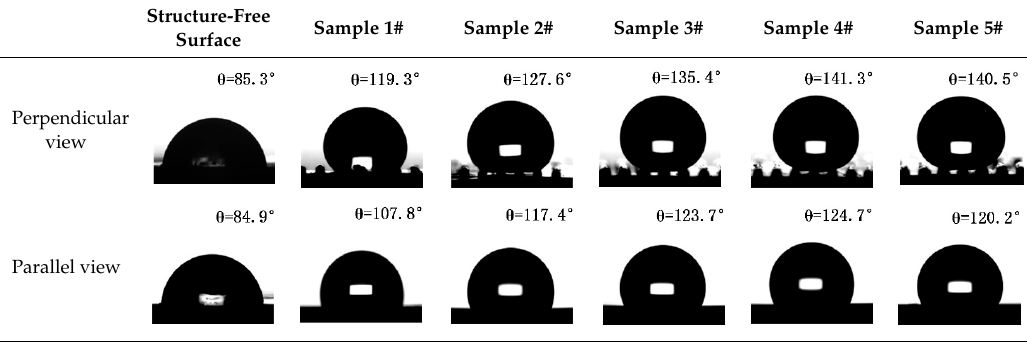
Figure 12. The evolutions of WCAs versus deposition time for PP micro-structured part surfaces. 4. Conclusion The micro-structured core insert with regular micro-groove array structure processed by WEDM-LS was applied to micro-UPM, and the micro-structure was replicated using polypropylene. This work studies the effect of micro-UPM on the processability of polypropylene under different process parameters. The primary findings are presented as follows: (1) A combined mold was assembled with an upper plate, a lower plate, a material chamber, a channel insert and a micro-structured core insert. Applying the combined mold in micro-UPM, the micro-structured parts with different shapes and sizes can be prepared, which has a simple process, low production cost and good flexibility. (2) The effect of ultrasonic energy, welding pressure and holding time was investigated for the fabricating of micro-structured PP parts during micro-UPM. The viscosity on the PP polymer was lower when ultrasonic energy is strengthened, leading to it filling in the micro-groove arrays more. Higher welding pressure allows PP melt to fill at a faster rate, reducing heat loss during the filling process. Besides, holding time is one of the critical parameters to prevent melting reflux and reduce product shrinkage and deformation. At the conditions of 1000 J, 115 kPa and 8 s, micro-structured parts with flexible shape and size can be successfully fabricated, the replication rate reaches about 96.52% and roughness Ra is about 0.85 μ m. (3) By using the micro-structured core insert processed by WEDM-LS, micro-UPM successfully produced micro-structured parts with hydrophobic surface. The WCA in the perpendicular view on the micro-structured parts can reach a maximum of 146.8°. (4) The conclusions above are drawn from different trials, which proves the reproducibility of the molding process. However, more research on micro-UPM, such as the fabrication of composite materials, is still needed in the future.